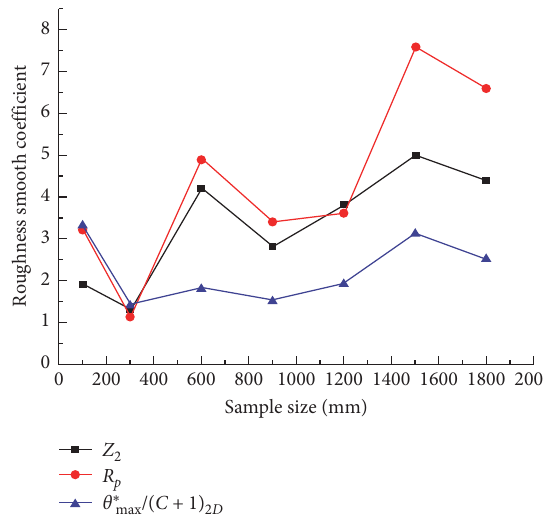
Figure 13: Roughness smooth coefficients of m